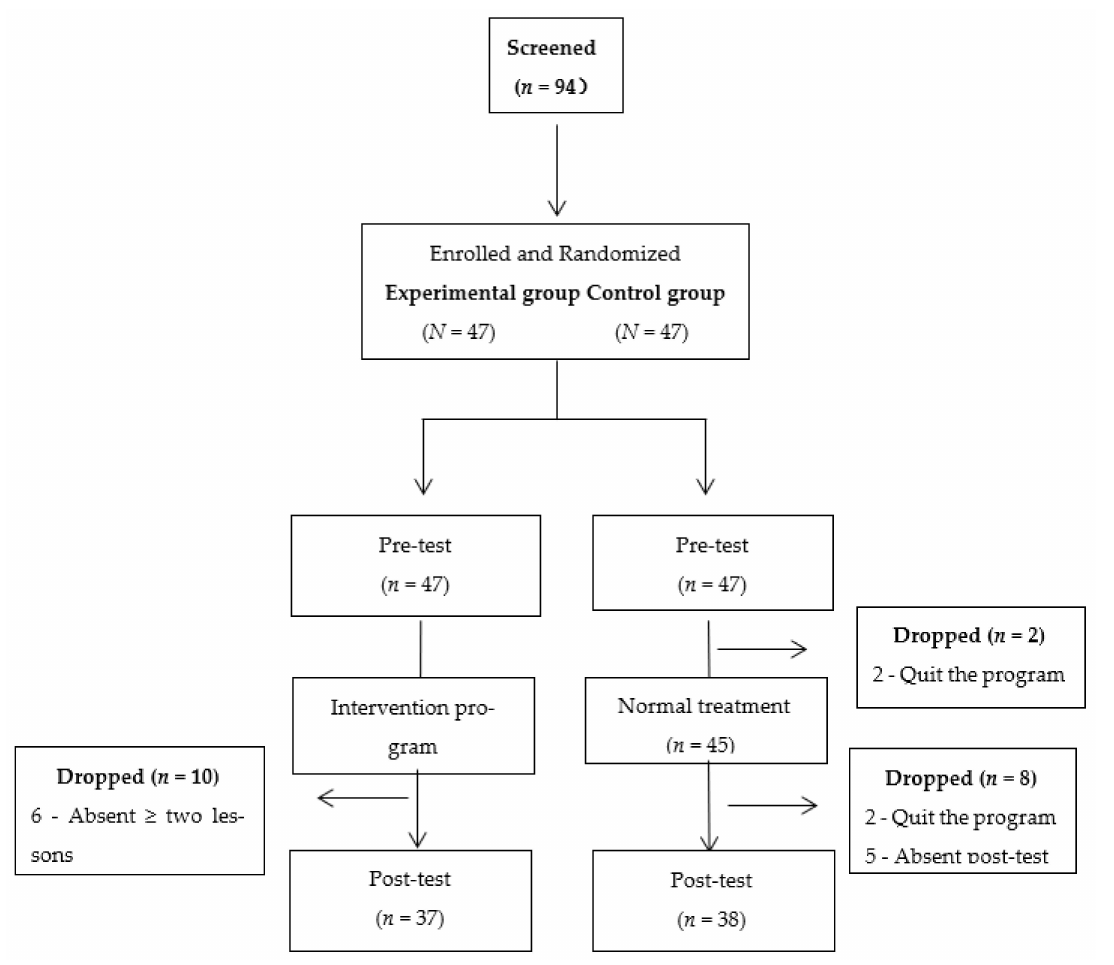
Figure 1. Participant selection process flow